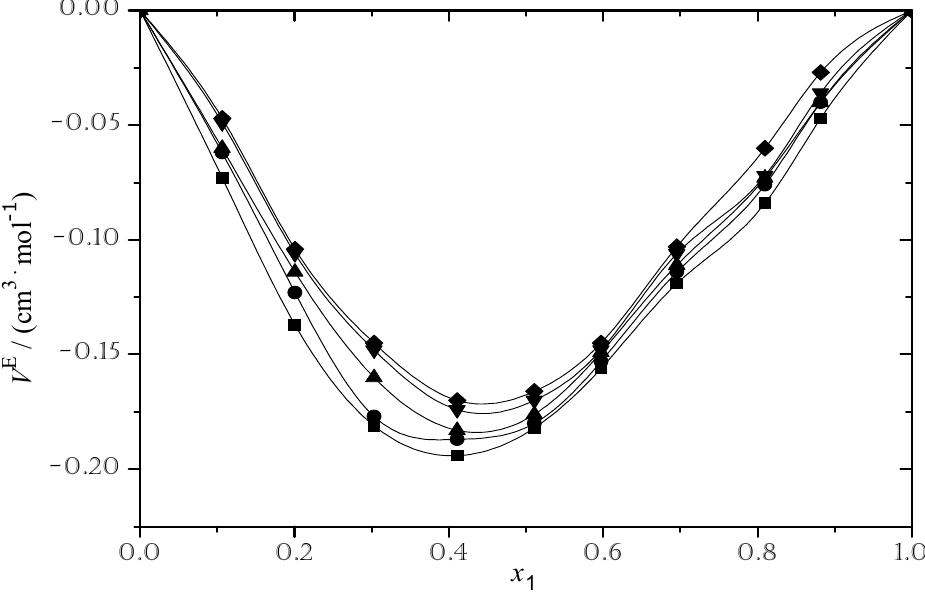
Figure 1. Excess molar volumes ( V E ) with mole fraction for DEG (1) + DMSO (2) system at various temperatures: ■ 293.15 K; ● 298.15 K; ▲ 303.15 K; ▼ 308.15 K; ♦ 313.15K.